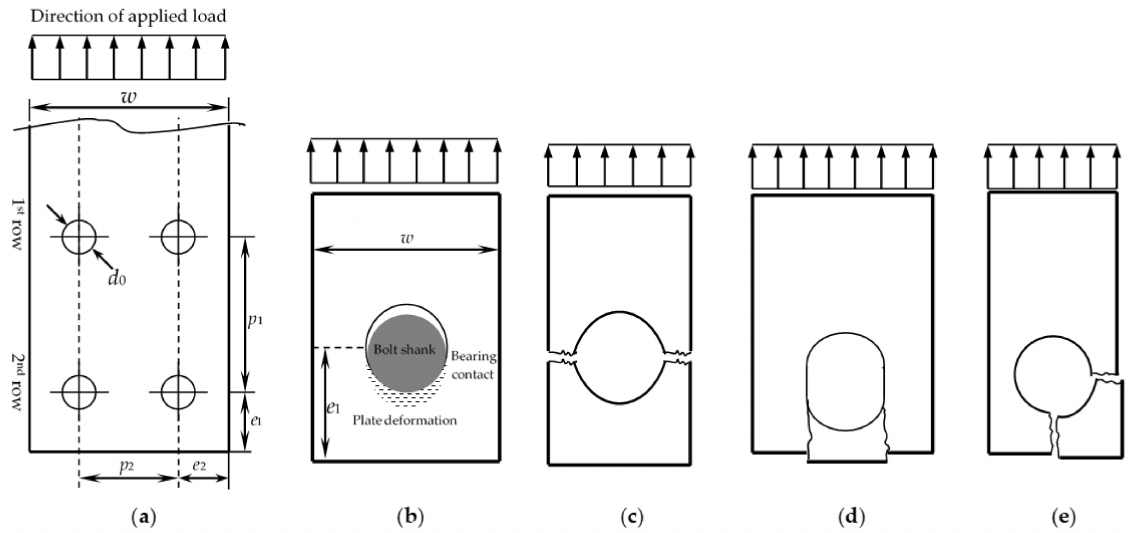
Figure 8. Geometry and failure modes of FRP plate-to-plate connections [23]; ( a ) Connection geometry; ( b ) Bearing failure; ( c ) Net-tension failure; ( d ) Shear-out failure; ( e ) Cleavage